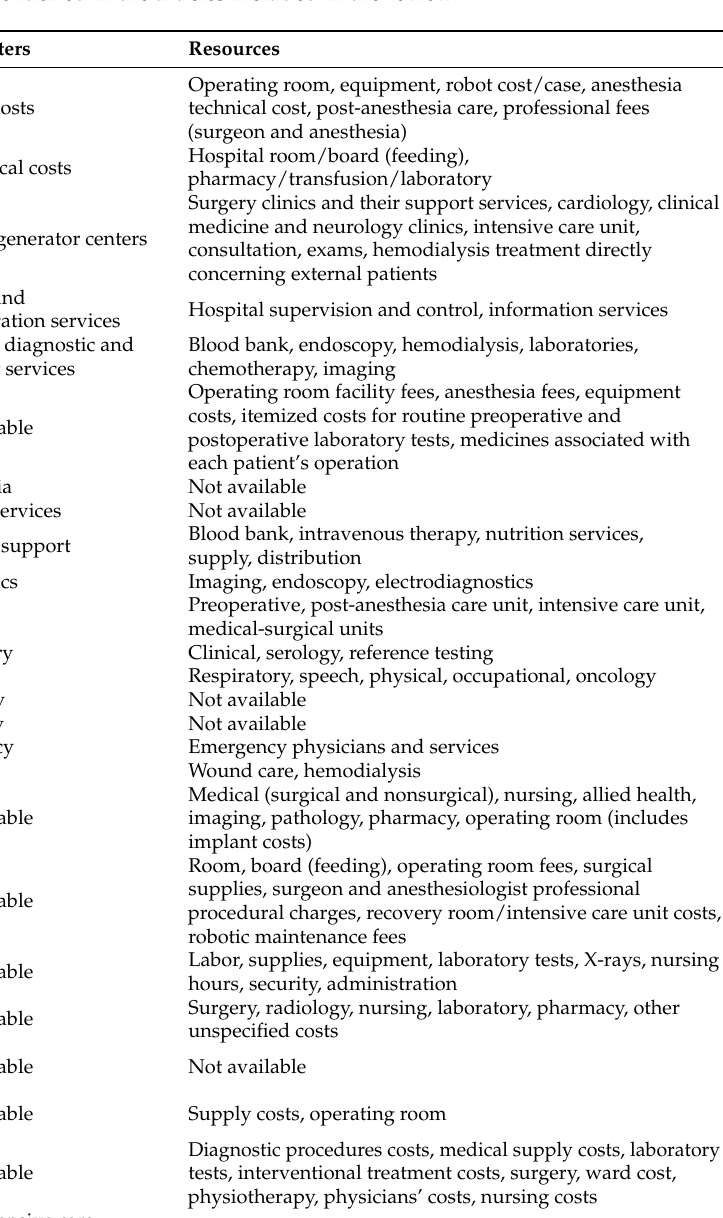
Table 4. Types of costs mentioned in the articles included in the